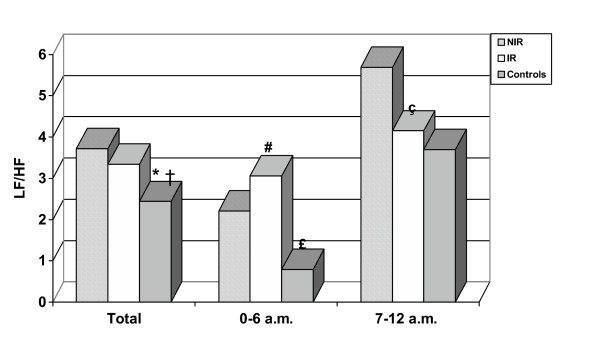
LF/HF value in offsprings of type 2 diabetic patients and control. IR: insulin resistant offsprings of type 2 diabetic patients, NIR: non insulin resistant offsprings of type 2 diabetic patients, LF/HF: low frequency/high frequency, hours of Holter registration: 0–6 am= night time, 7–12 am = morning. *p.0.016 controls vs IR; †p:0.002 control vs NIR; # p:0.015 IR vs NIR; £ p:0.0001 controls vs NIR and IR; ç p:0.043 controls vs NIR.